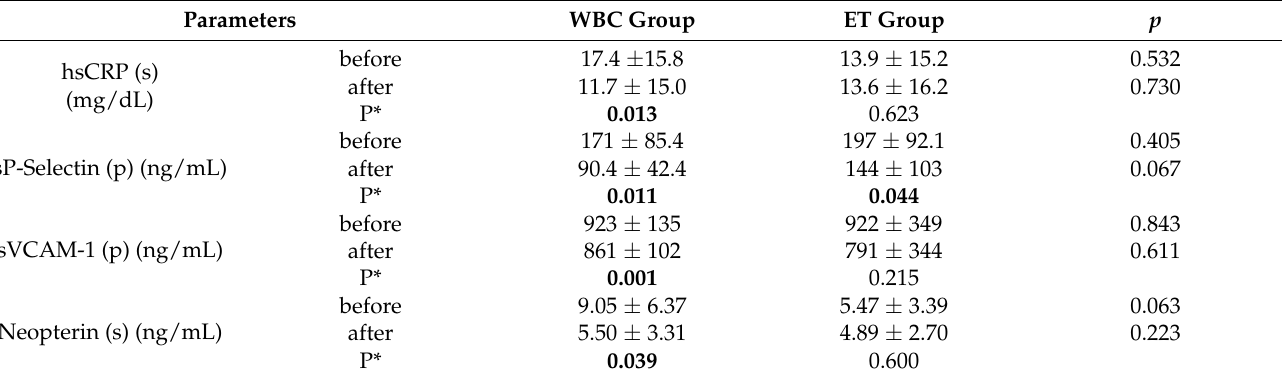
Table 2. Endothelium parameters (mean value ± standard deviation SD) in AS patients before and after the treatment in the studied